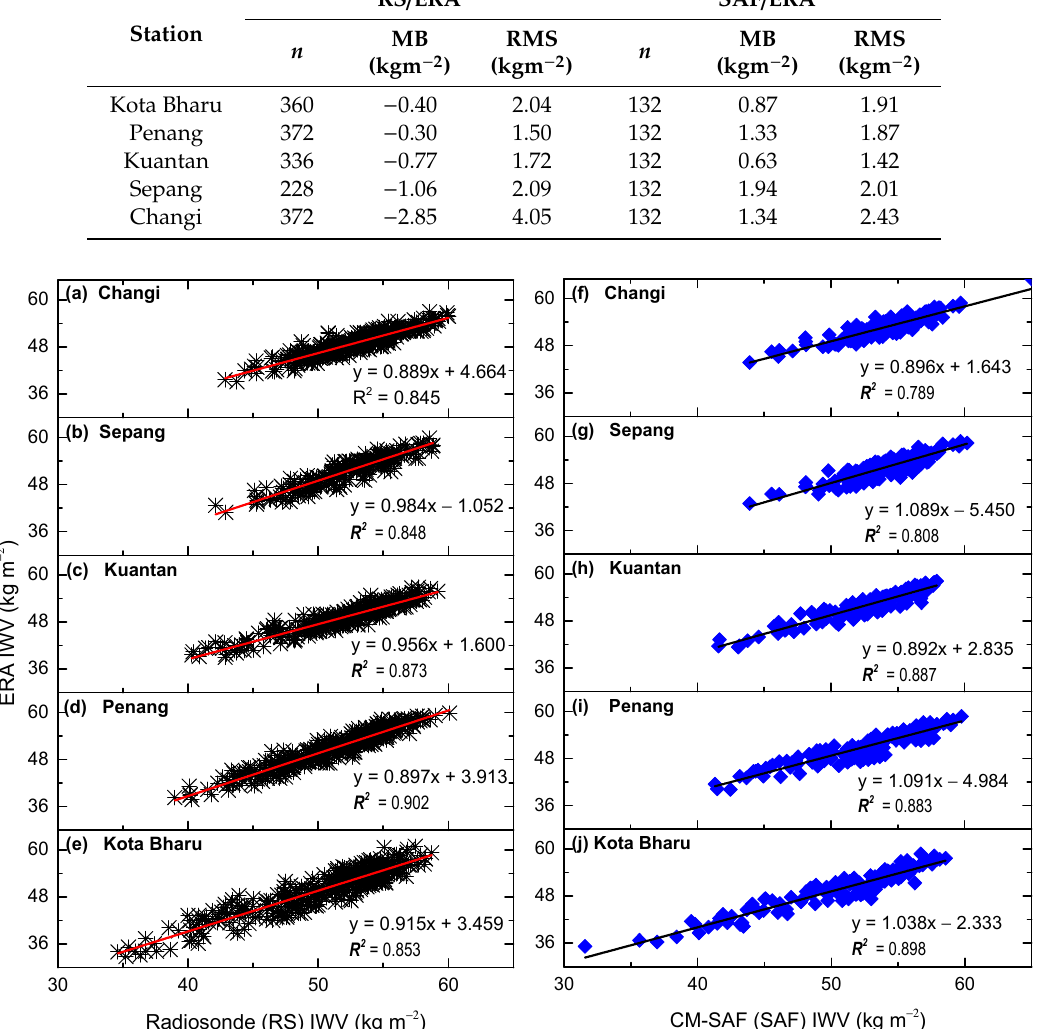
Figure 3. Scatterplots of monthly means of IWV from ERA compared with IWV from: Radiosonde (( left ) panel) and CM-SAF (( right ) panel) for the five selected WMO stations in Peninsular Malaysia.